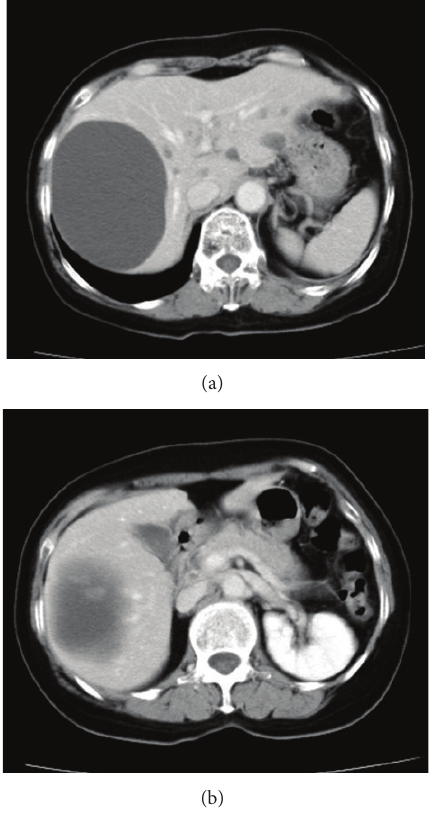
Figure 1: Abdominal contrast-enhanced computed tomography performed in September 2011 shows multiple cysts in both hepatic lobes. Nodular structures can be observed on the caudal side of a giant